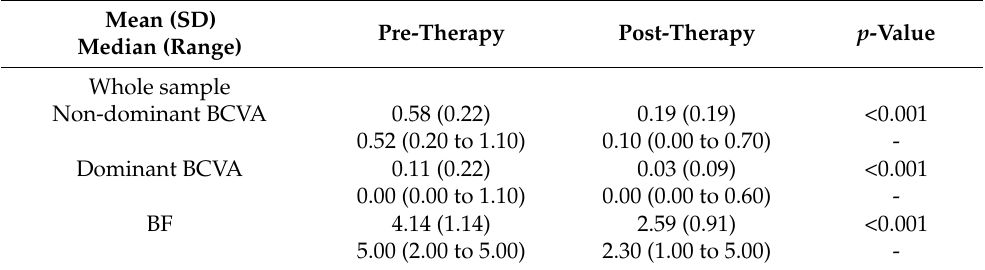
Table 1. Summary of the main outcomes obtained in the whole sample as well as in the anisometropic and isometropic groups. Abbreviations: SD, standard deviation; BCVA, best corrected visual acuity; BF, binocular